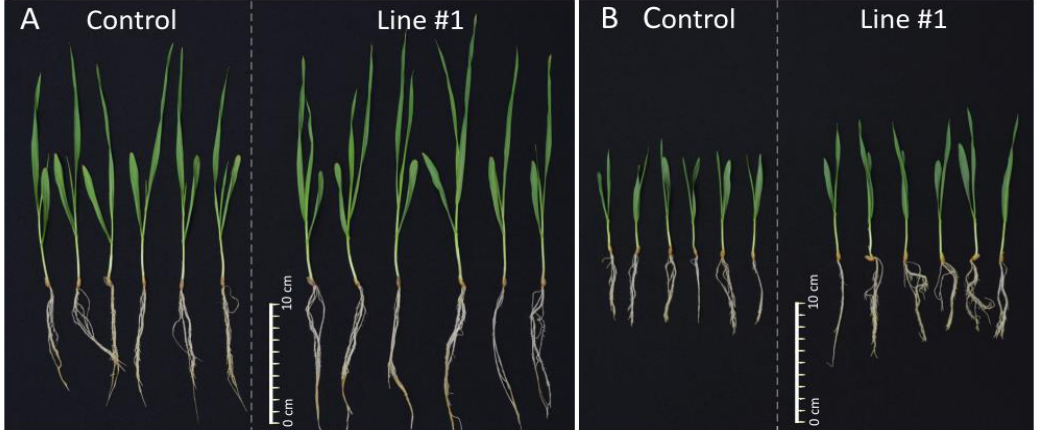
Figure 5. Representative pictures of 14-days-old seedlings of the non-transgenic control and the line #1. ( A ) 14-days-old seedlings of the non-transgenic control and the line #1 grown in normal conditions (Hoagland medium). ( B ) 14-days-old seedlings of the non-transgenic control and the line #1 grown in salt stress conditions (Hoagland medium supplemented with NaCl 200 mM).